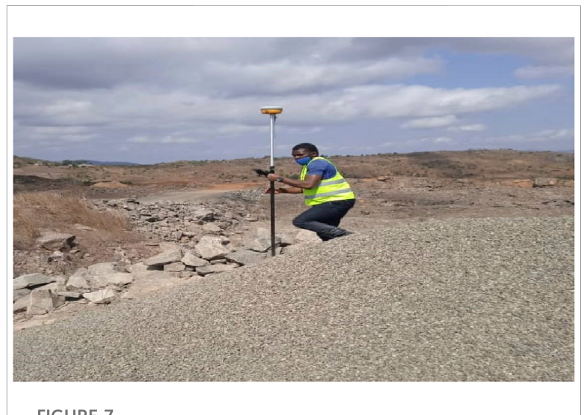
FIGURE 7 Recording elevation at different points of the stockpile.